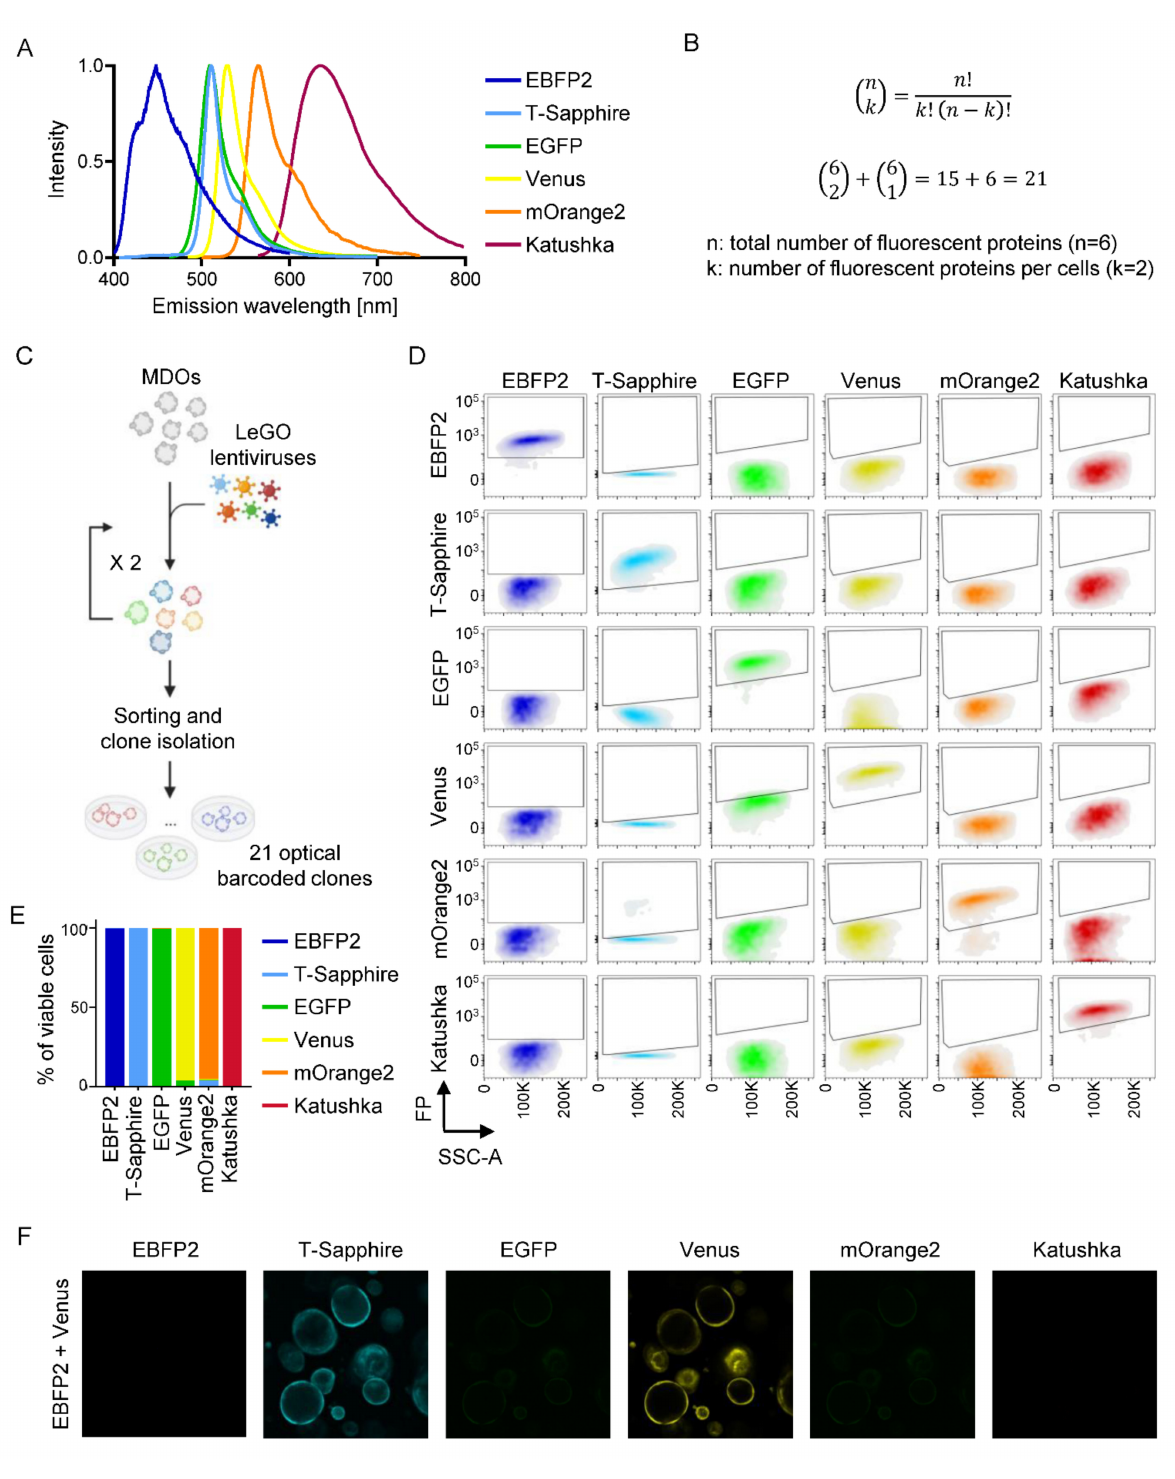
Figure 5. Optical barcoding to study clonal dynamics in CRC. ( A ) Histogram representing the emission spectra of the six different fluorescent proteins. ( B ) Binomial coefficient calculation to obtain the total number of clones that can be uniquely labeled with the LeGO optical barcoding system combining up to two colors per cell. ( C ) Schematic representation of the optical barcoding procedure of KPN organoids. ( D ) Flow cytometry plots of clones barcoded with one fluorescent protein. Each row corresponds to one clone. ( E ) Percentage of the fluorescence color detected by flow cytometry for the samples shown in ( D ). ( F ) Confocal images of the clone labelled with T-Sapphire and Venus fluorescent